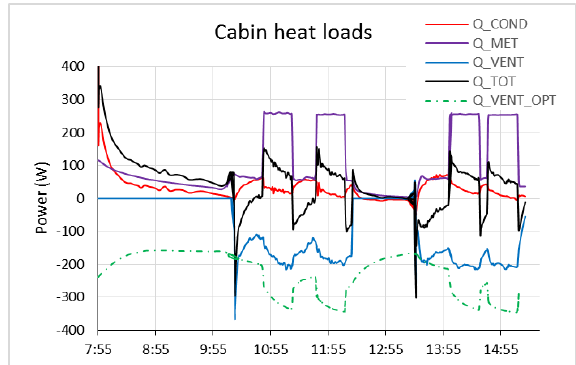
Fig. 6. Summer test for subject N.1-4. Cabin heat